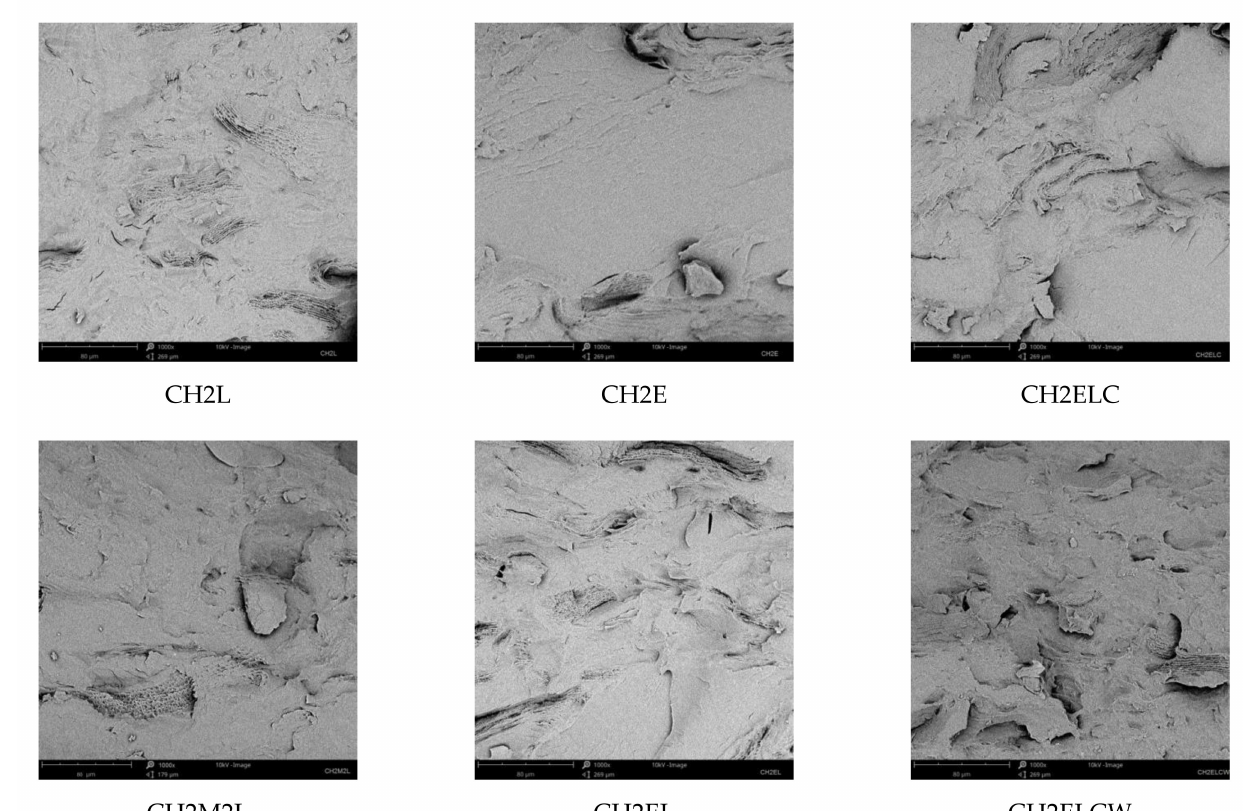
Figure 8. SEM images of chitosan/starch-based samples modified with PVA and lignin, 1000 × .